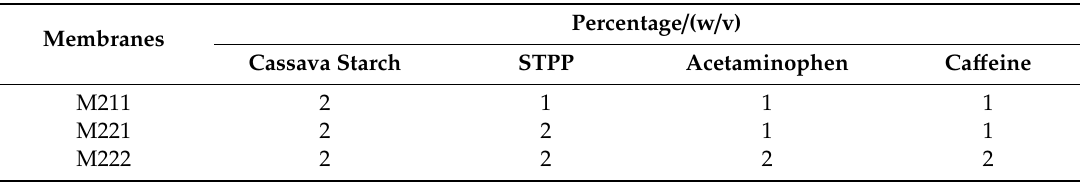
Table 1. Compositions of membrane for electrode modification.